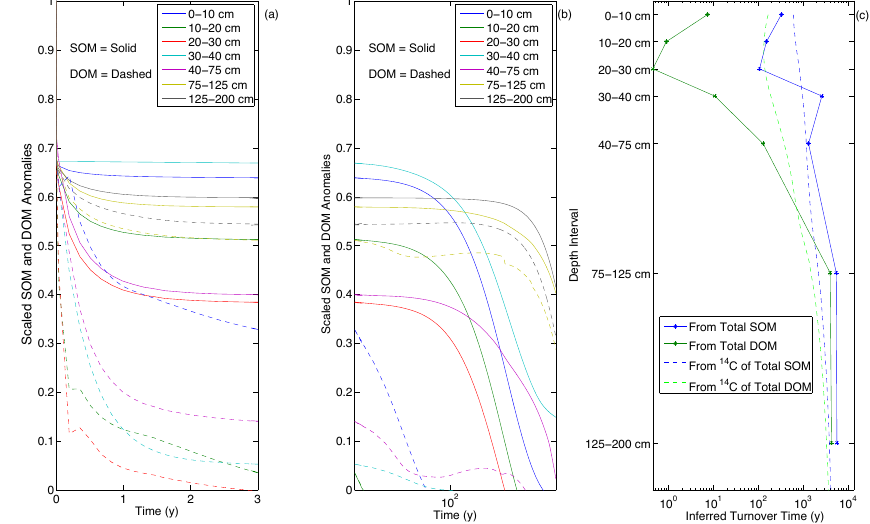
Figure 8. (a, b) Predicted 5000 year time histories of the scaled total SOM and total DOM anomalies resulting from a doubling of all compounds in the specified depth intervals ( a shows first 3 years on a linear time scale and b shows 3–5000 years on a log time scale). (c) Inferred first-order turnover times and 14 C ages for total SOM and total DOM as a function of depth interval following the